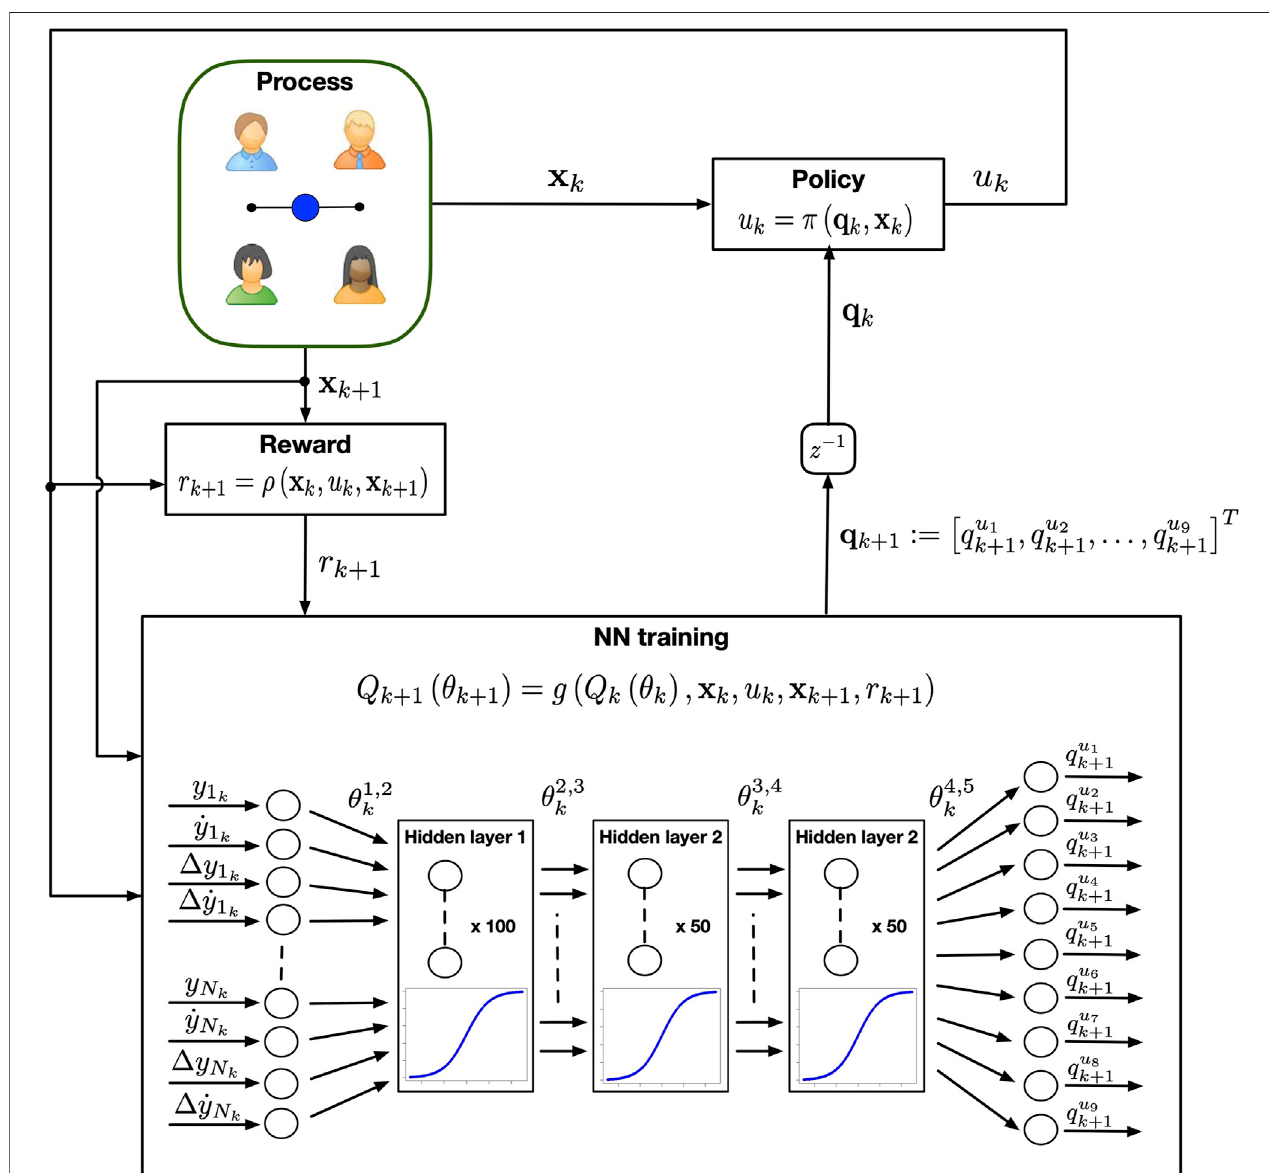
FIGURE 1 | Control architecture of the cyber player playing the mirror game in a group. At each iteration k , the DQN controller observes the state of the game and chooses the control input u according to the estimated neural network. The process evolves in a new state and the CP receives a reward r . The set of reward, previous and current state are then used to update the weights of the neural